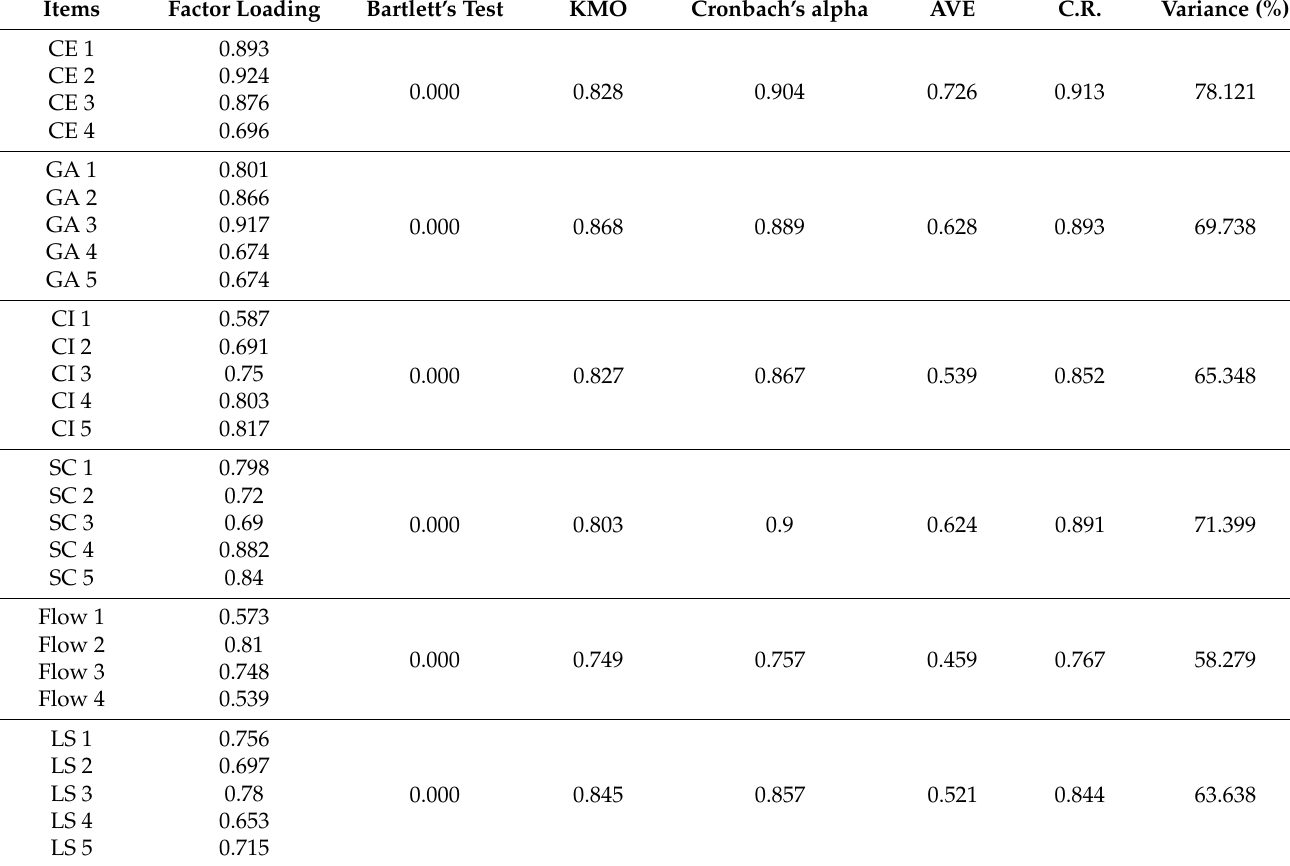
Table 2. Test of construct validity and